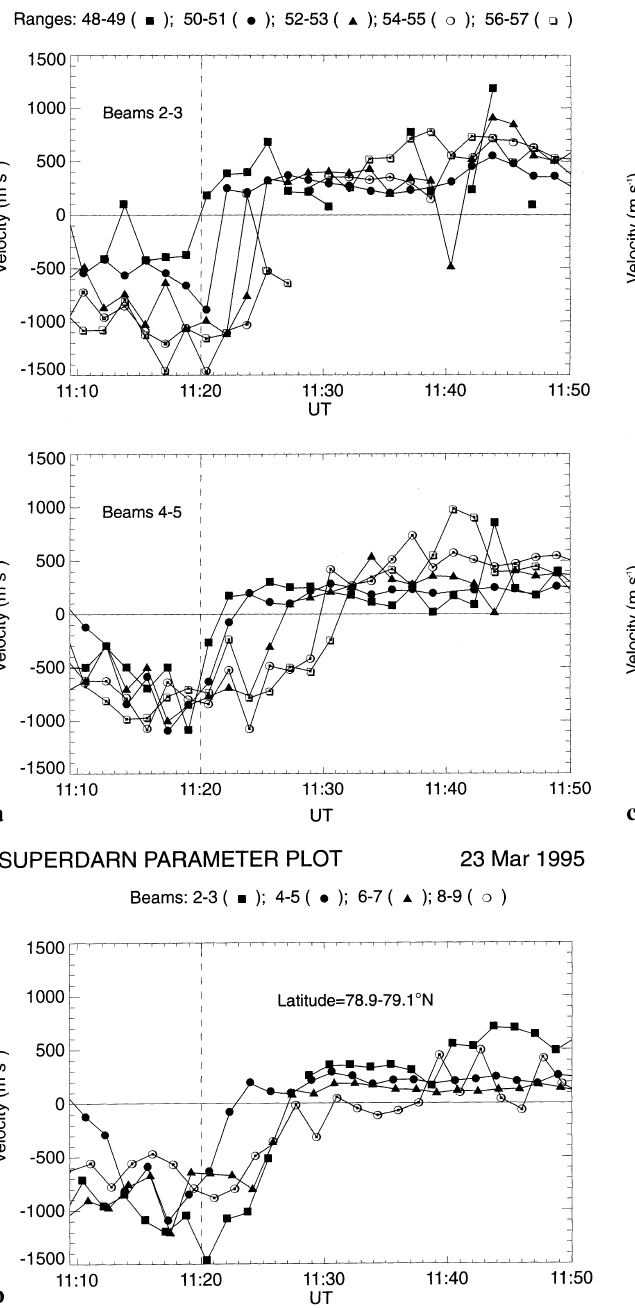
b Shows data obtained for cell clusters centred in the magnetic latitude band 78.9 (cid:176) –79.1 (cid:176) at various local times in the noon sector, showing the east-west propagation of the antisunward-to-sunward flow transition; specifically the data are for beams 2–3 ranges 54–55 ( solid square ), beams 4–5 ranges 50–51 ( solid circle ), beams 6–7 ranges 48–49 ( solid triangle ), and beams 8–9 ranges 48–49 ( open circle ). c Shows data from successive range gate pairs of beams 12–13 ( upper panel ) and 14–15 ( lower panel ), showing the eastward motion of the sunward-to-antisunward flow transition observed in the eastern part of the radar f-o-v in the